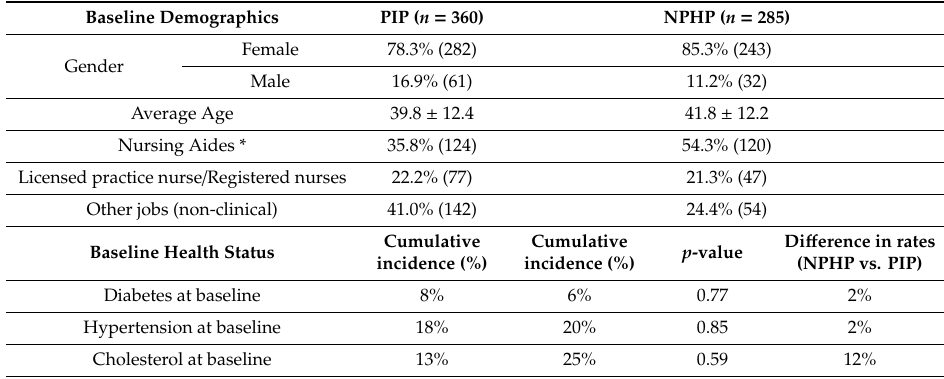
Table 1. Baseline characteristics of skilled nursing facility employees (all jobs): 3 participatory intervention program (PIP) and 3 non-participatory health promotion (NPHP)